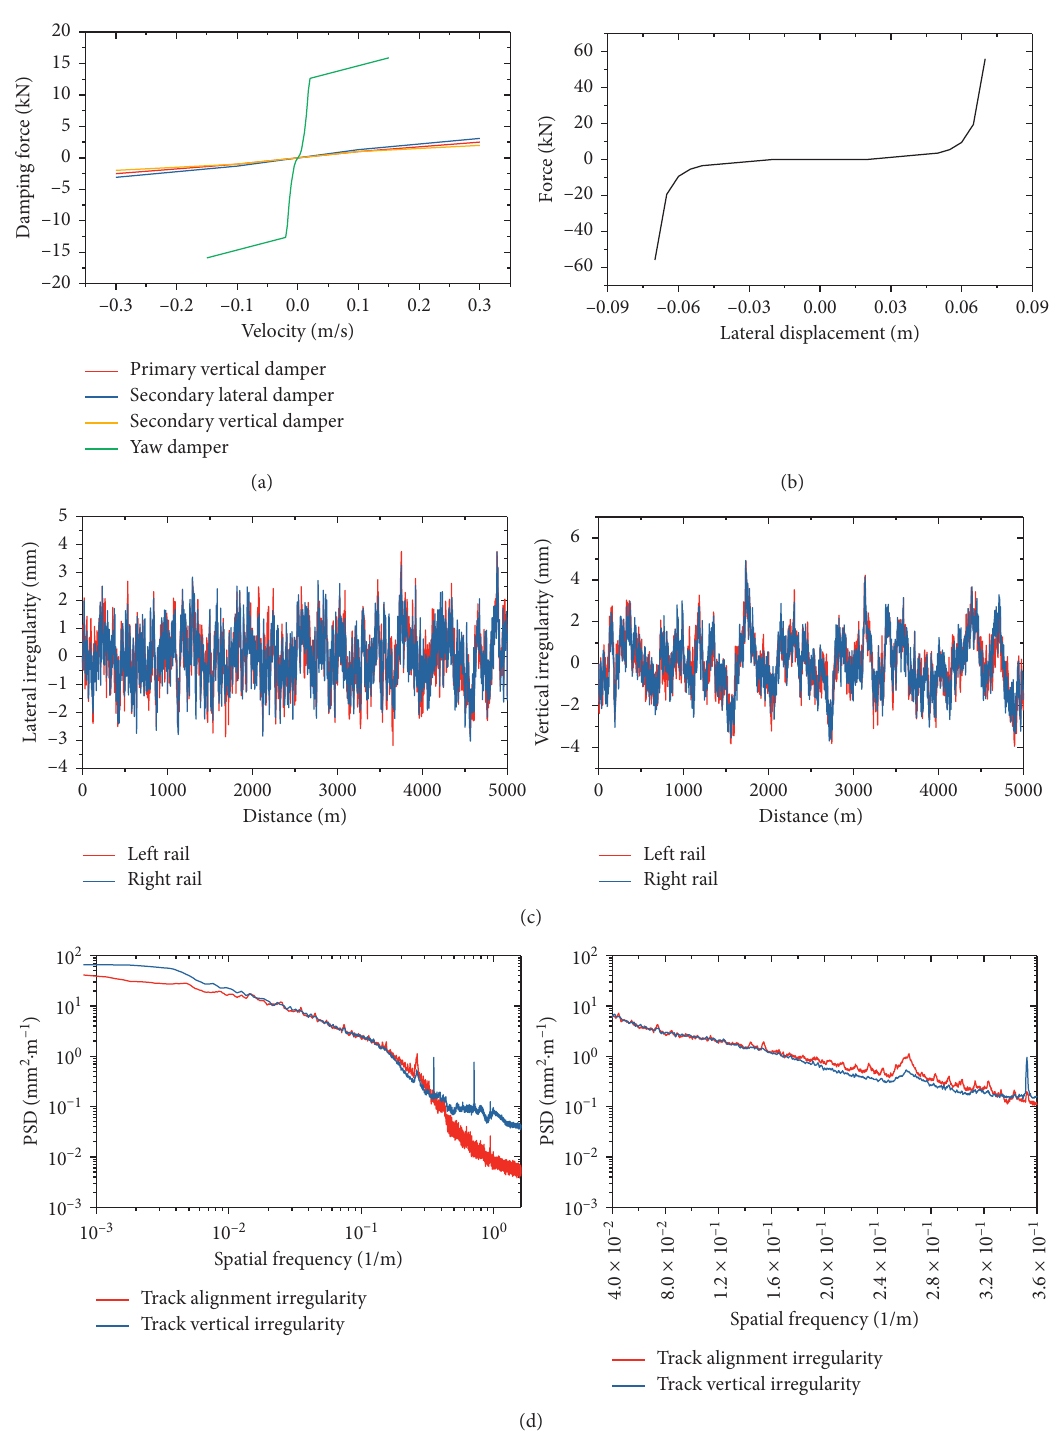
Figure 6: Nonlinear parameters of the simulation model. (a) Damping forces of primary vertical damper, secondary lateral damper, secondary vertical damper, and yaw damper. (b) Stop force of the secondary lateral stopper. (c) Track irregularity. (d) The PSD of track